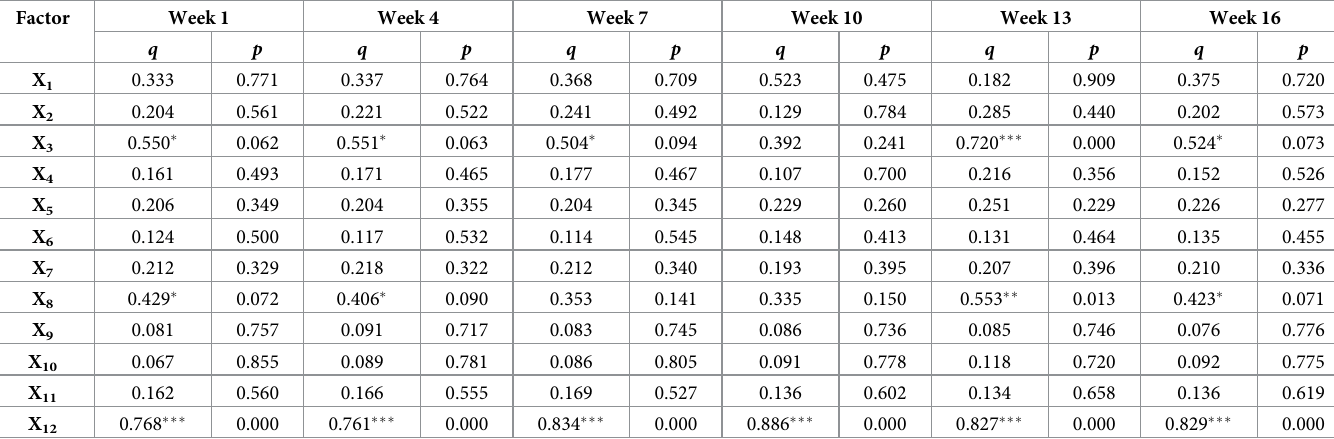
Table 4. Detection results of internet attention time series evolution factor.